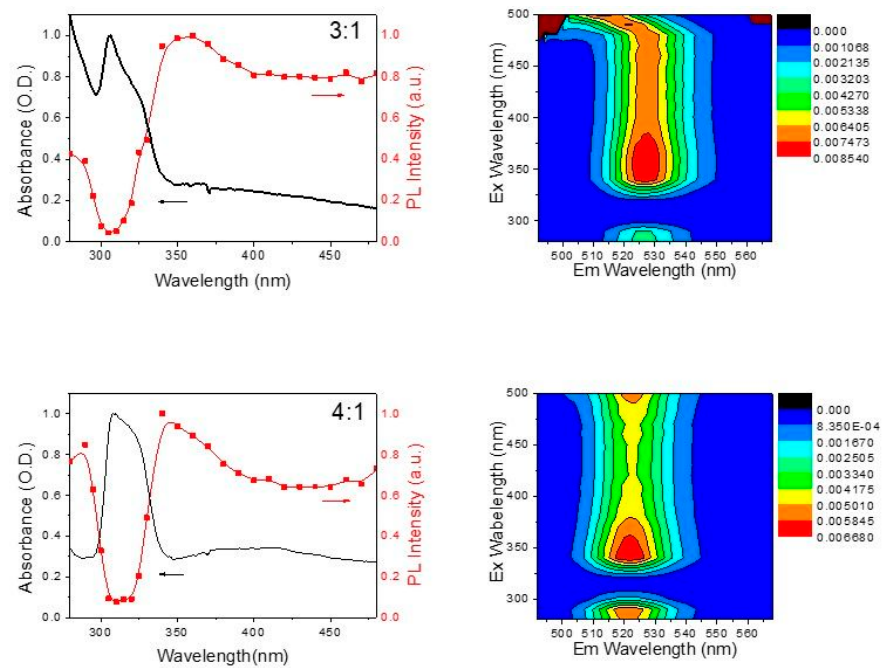
Figure 10. Excitation spectra ( λ em = 520 nm, red squares) and contour curves of the fluorescence for 3:1 and 4:1 samples. The respective absorption spectra (black lines) from Figure 6 are also reported for